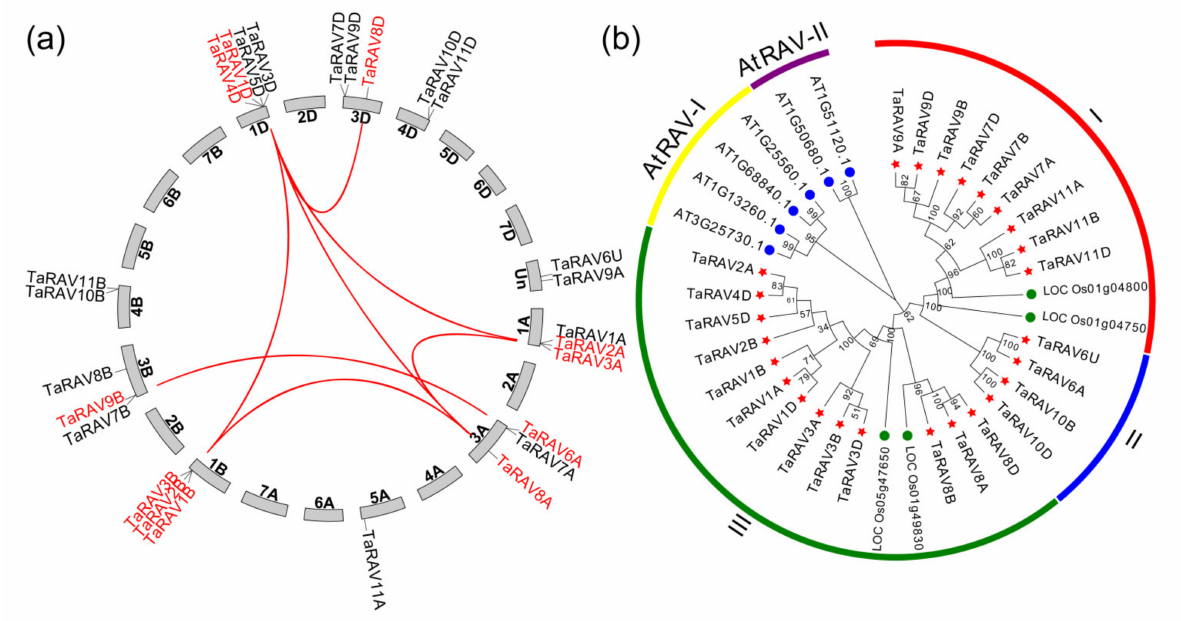
Figure 1. Chromosome location and Phylogenetic analysis of RAV genes in wheat. ( a ) Chromo- some location, and segmentally duplicated gene pairs of wheat ( Triticum aestivum ) RAV genes; ( b ) Phylogenetic tree of 26 wheat RAV TFs, 6 Arabidopsis RAV TFs, and 4 rice RAV